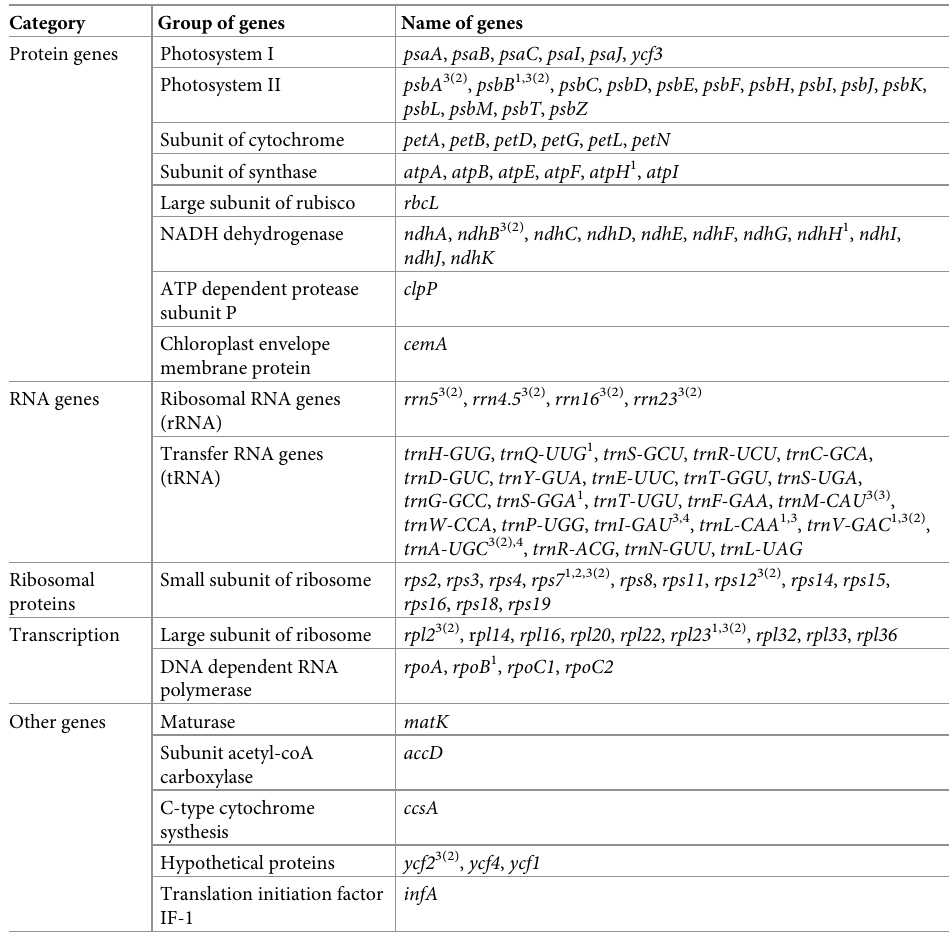
Table 3. Gene present in the chloroplast genome of